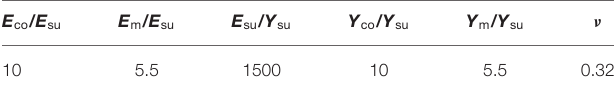
TABLE 1 | Material property ratios to study the strengthening effect in bilayer coated spheres.